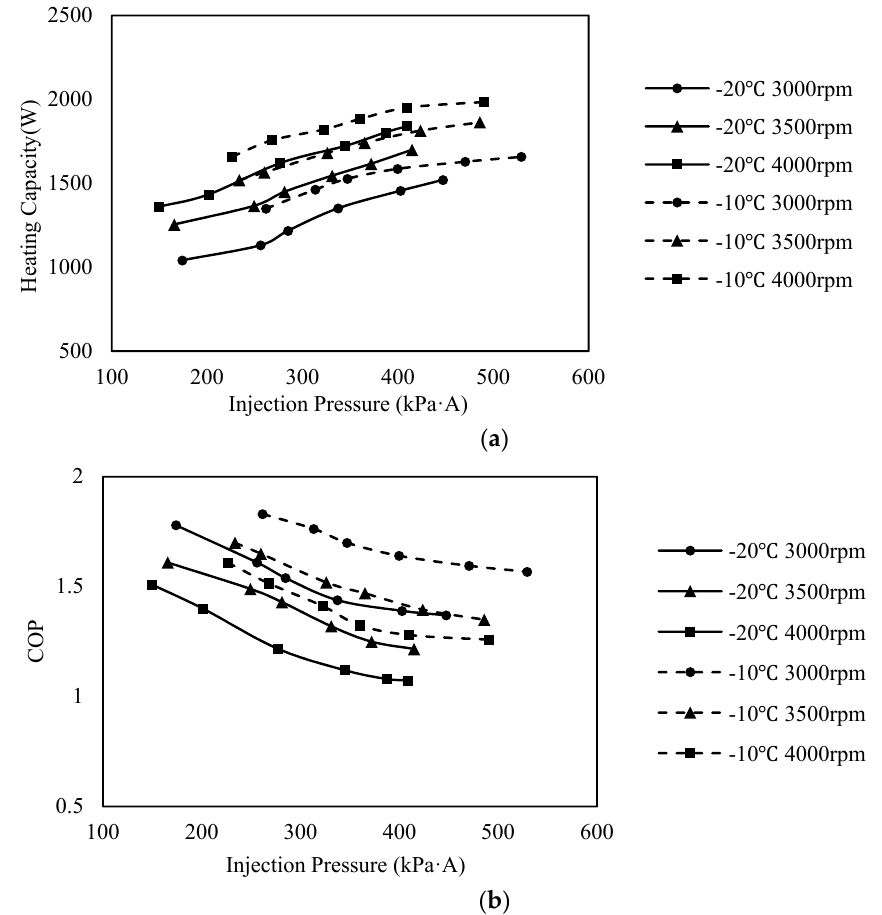
Figure 4. Heating capacity and COP under different injection pressures. ( a ) Heating capacity; ( b ) Heating COP.